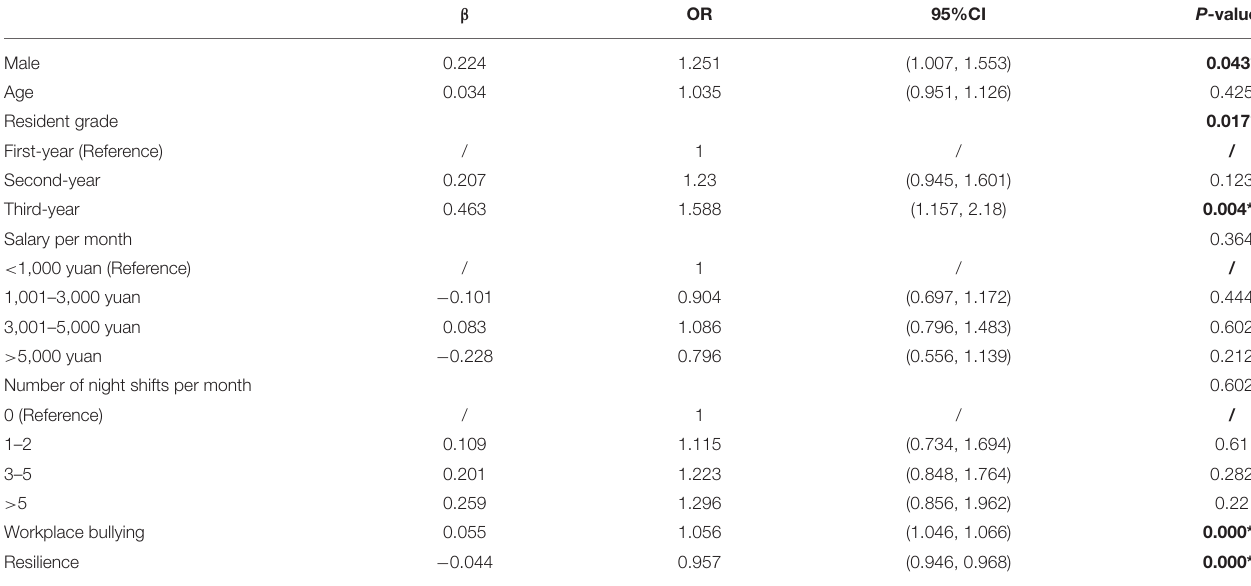
TABLE 2 | Binary logistic regression analysis of insomnia.